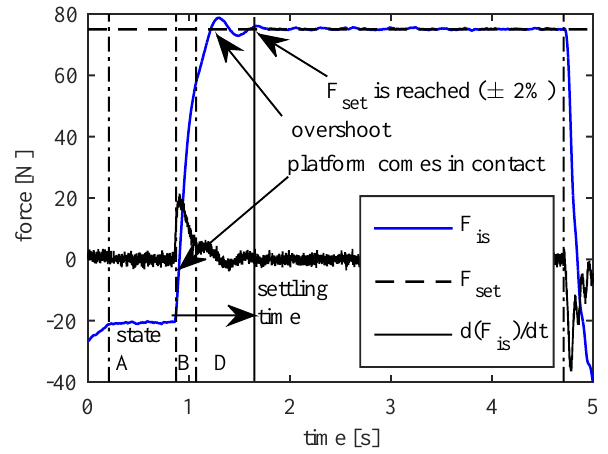
Figure 4. Progression of the force during contact establishment, Figure 7. Progression of the force during contact establishment, force control and release force control and release. Figure 2. General kinematic parameters